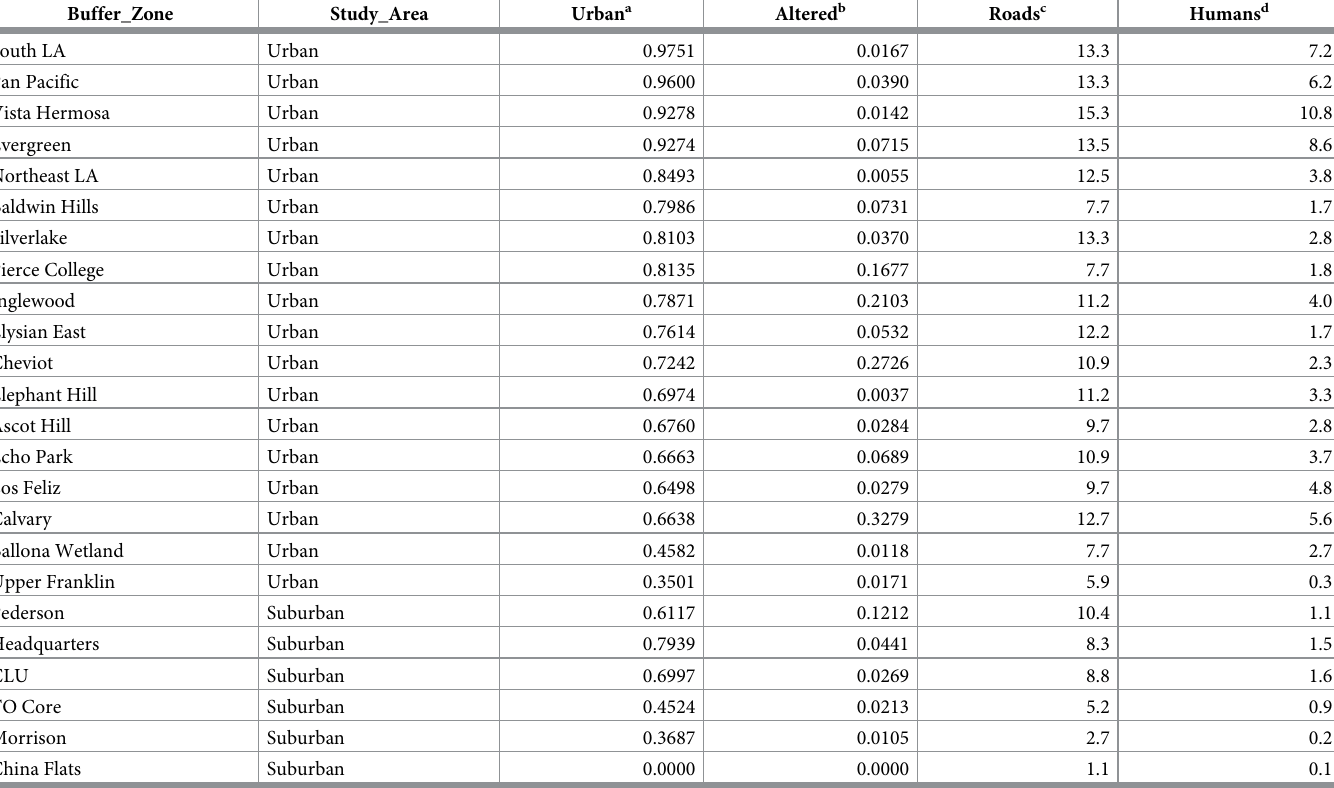
Table 1. Land use in the scat transect buffer zones. Land use and human development characteristics in 18 urban and 6 suburban scat transect buffer zones. Spatial anal- ysis was done in ArcMap Desktop 10.6 (Esri, Inc.; Redlands, CA) using